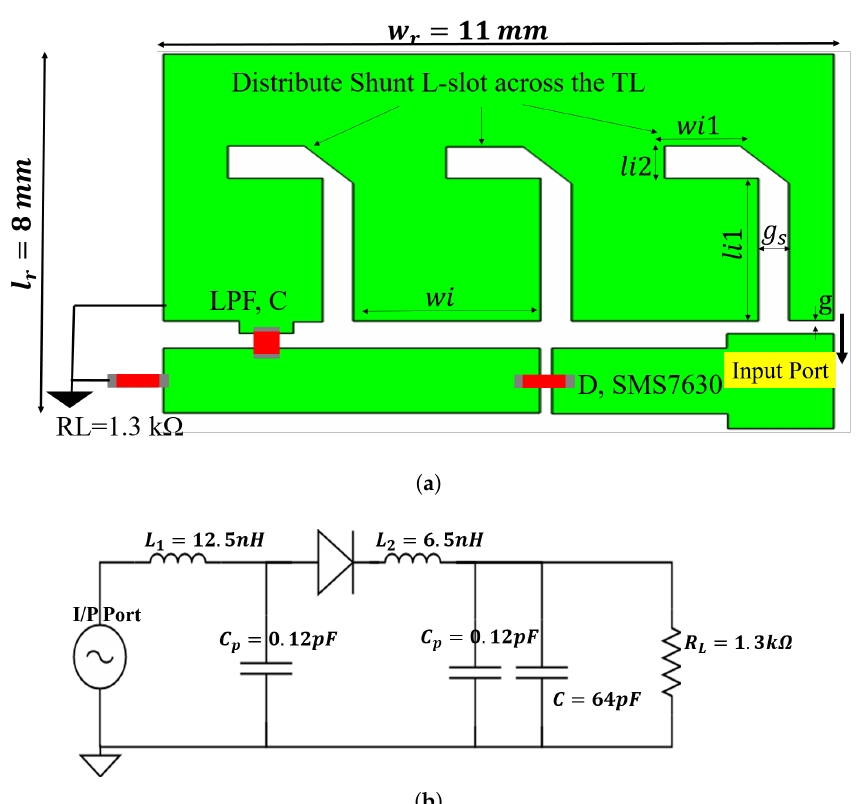
Figure 3. The RF rectifier circuit ( a ) rectifier layout and the dimensions are as follows: w i 1 = 1.7